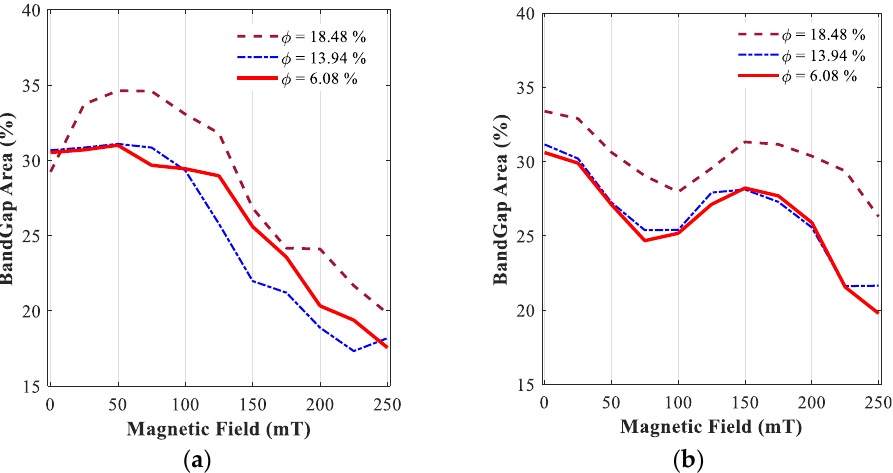
Figure 15. Evolution of active bandgap areas percent in the range of 0 and 5 kHz and different magnetic fields (0 < B < 250 mT) with various iron volume fractions, cylindrical core radius, and arm angles: ( a ) L / R = 5 & θ = 0; ( b ) L / R = 8 & θ = − 1 ◦